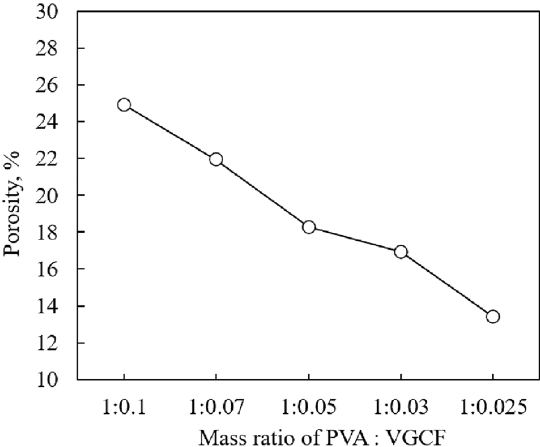
Figure 4. Effect of mass ratio of PVA and VGCF on porosity.